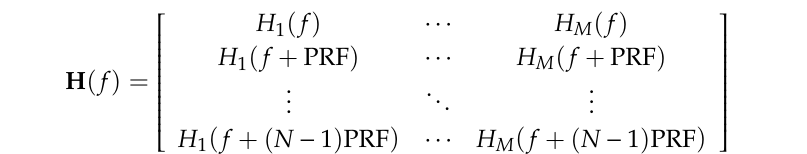
(c) Figure 11. Reconstructed Doppler spectra via different slant range velocities for reconstruction in the non-band - limited case, while the actual target slant range velocity is 10 m/s. ( a ) The slant range velocity for reconstruction is 5 m/s. ( b ) The slant range velocity for reconstruction is 8 m/s. ( c ) The slant range velocity for reconstruction is 10 m/s. According to the signal power distribution phenomenon shown in Figures 10 and 11, the SIR could be introduced to judge whether the multichannel spectrum is well reconstructed. Furthermore, the SIR could be expressed as two types as follows: (